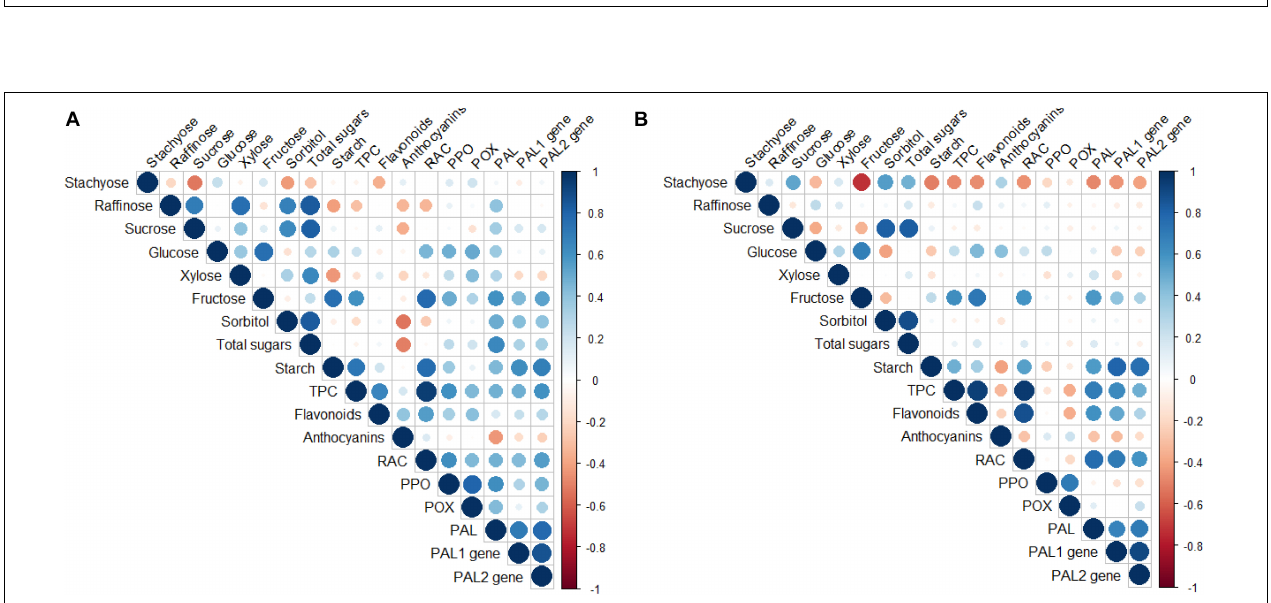
FIGURE 5 | Pearson’s correlation coefficient for the traits studied in the compatible (“SG/Adara”) and incompatible (“SG/Damas GF 1869”) graft-combinations, and ungrafted rootstocks at the leaf fall (A) and vegetative (B) periods, 3 years after grafting. PAL, Phenylalanine ammonia-lyase enzyme; PPO, Polyphenol oxidase enzyme; POX, peroxidase enzyme; RAC, Relative antioxidant capacity; TPC, Total phenolics content.